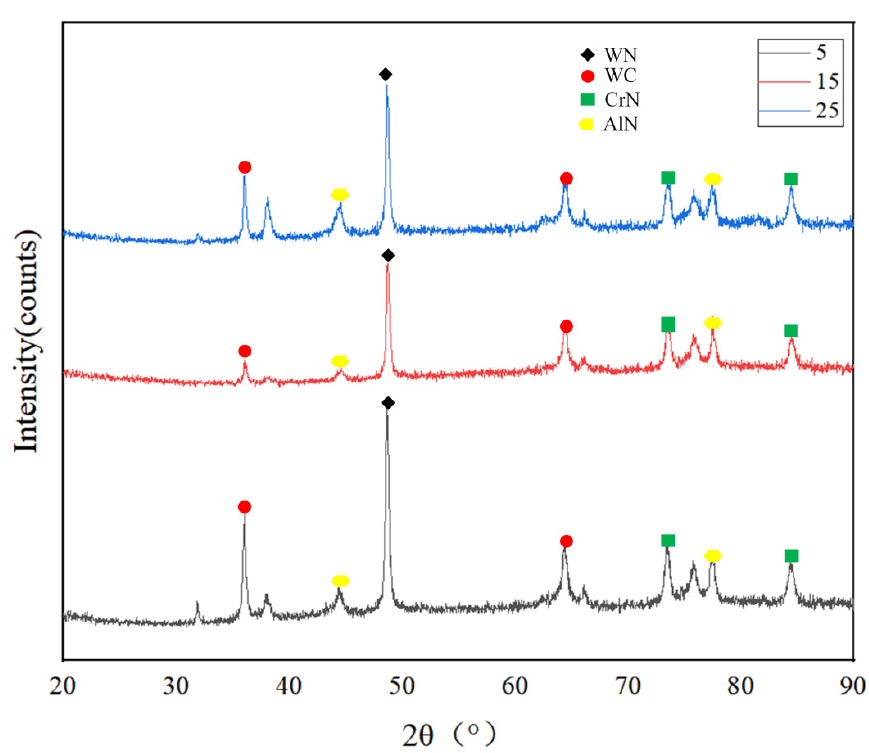
Figure 5. X-ray di ff raction pa tt ern of the AlSiTiN coating.